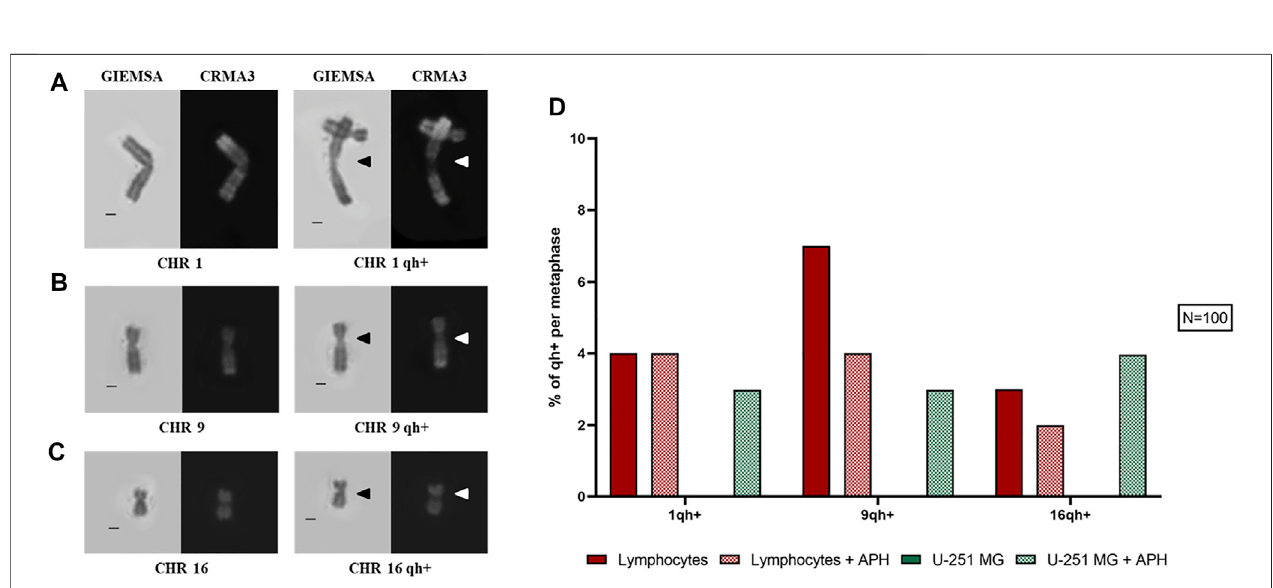
glioblastoma-speci fi c since the breaks/gaps induced by APH were only seen in U-251 MG cells ( Figure 5B ) and were not found in lymphocytes or fi broblasts under these experimental conditions.